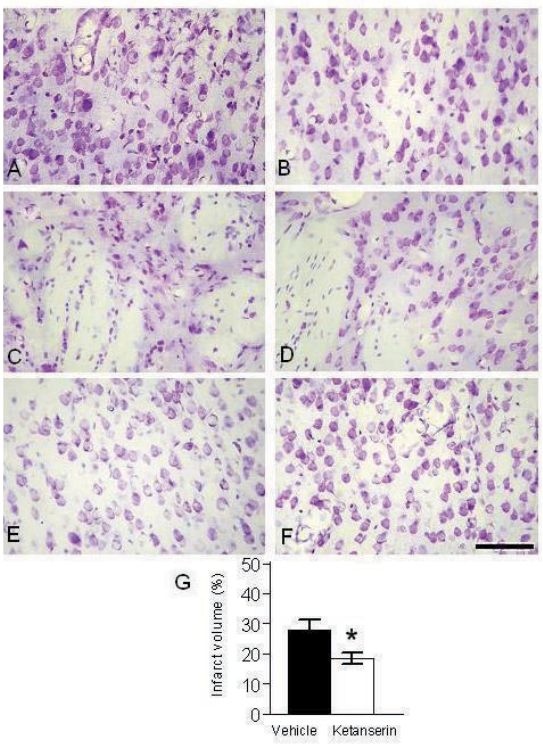
Figure 3. Microphotographs of layer II of the S1FL region of the Figure 2. Effects of ketanserin in non-ischemic rats (Saline/ cerebral cortex and dorsolateral striatum in rats treated Ketanserin) and ischemic rats (EMCAO/Ketanserin) with ketanserin or its vehicle (Cresyl violet staining). On compared to the effects of vehicle in non-ischemic the left (A,C,E) – ipsilateral hemisphere, on the right rats (Saline/Vehicle) and ischemic rats (EMCAO/ (B,D,F) –contralateral hemisphere. On A and B – S1FL Vehicle) on postural reflex of the contralateral ( A ) and in control (vehicle-treated) rat, on E and F – S1FL in ipsilateral body side ( B ) before ET1 (T0), at the 1h ketanserin-treated rat. On C and D – Striatum in control (H1), 4h (H4), day 1 (D1), day 3 (D3), day 7 (D7), and (vehicle-treated) rat. Sections of 30-μm thickness stained day 14 (D14). Data are presented as mean ± S.E.M. with 0.5% cresyl violet. Scale bar – 50 μm. On G – infarct and were analysed as follows ( p < 0.05): ▲ EMCAO/ volume derived from seven TTC stained sections. Mean Vehicle vs. Saline/Vehicle, * EMCAO/Vehicle vs. contra ± SEM are presented (Mann-Whitney test, * p <